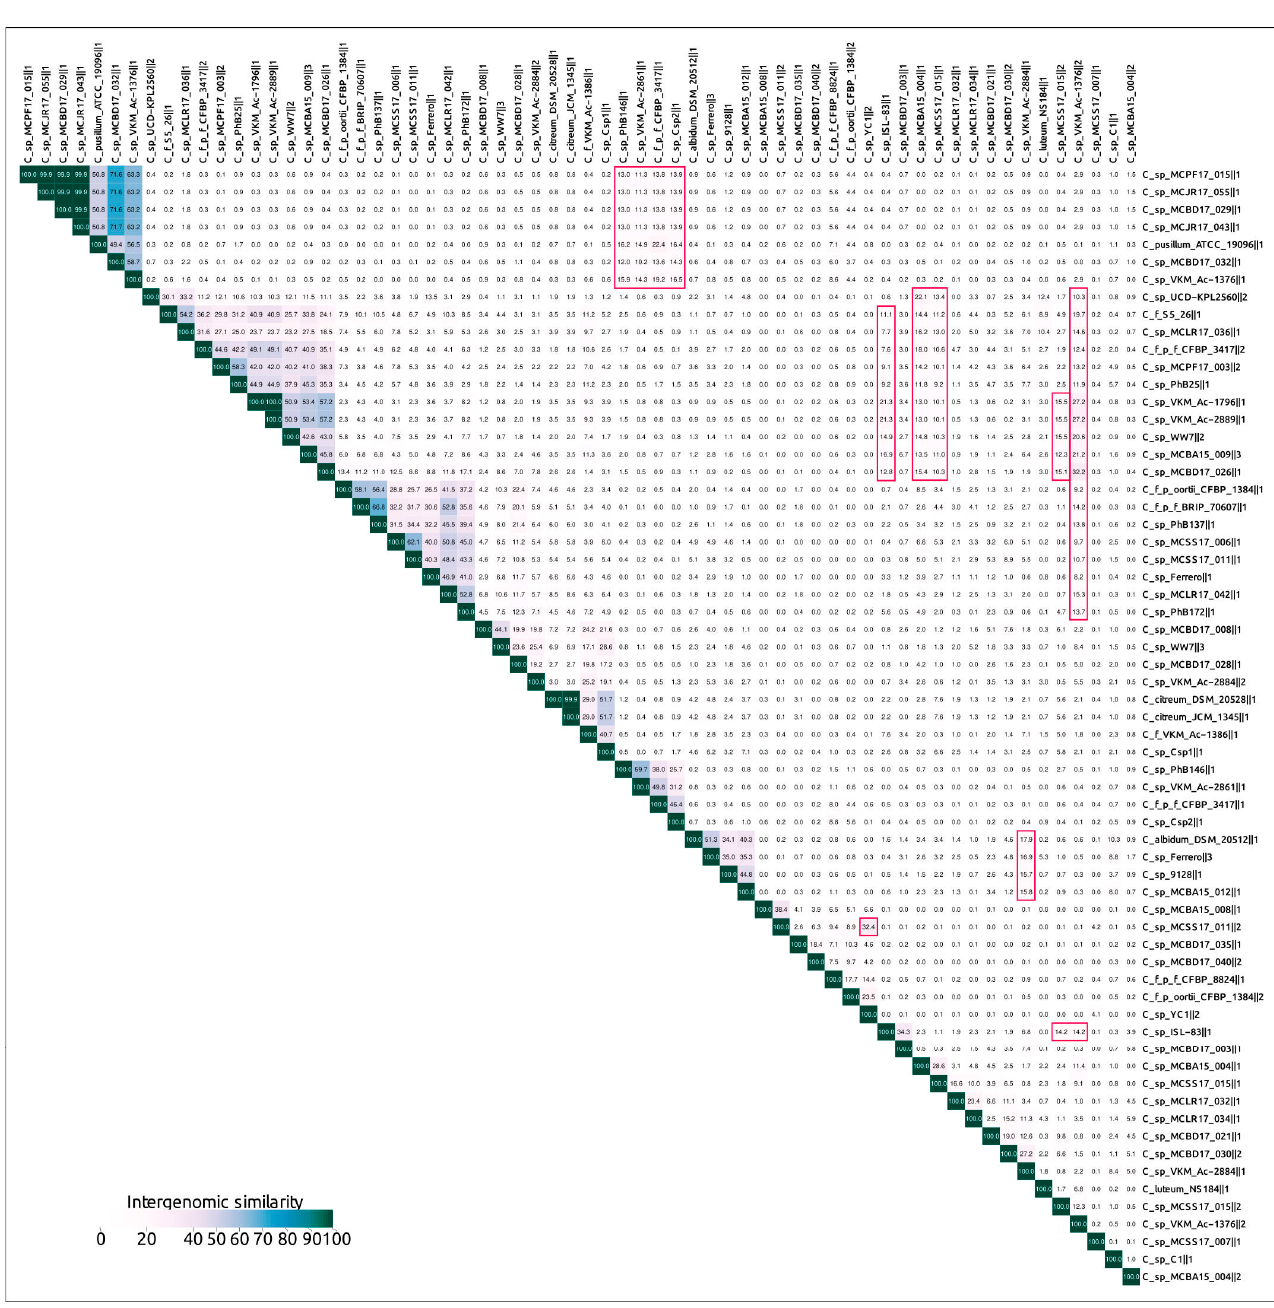
Figure 3. VIRIDIC-generated heatmap of 64 curated PRDs containing major capsid protein and terminase genes. The colour coding indicates the clustering of the phage genomes based on intergenomic similarity. The numbers represent the similarity values for each genome pair, rounded to the first decimal. Examples of heatmap islands indicating similarities between prophages not belonging to main clusters are outlined in red.